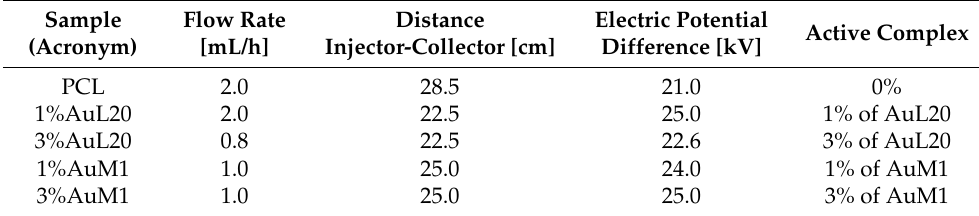
Table 1. Process